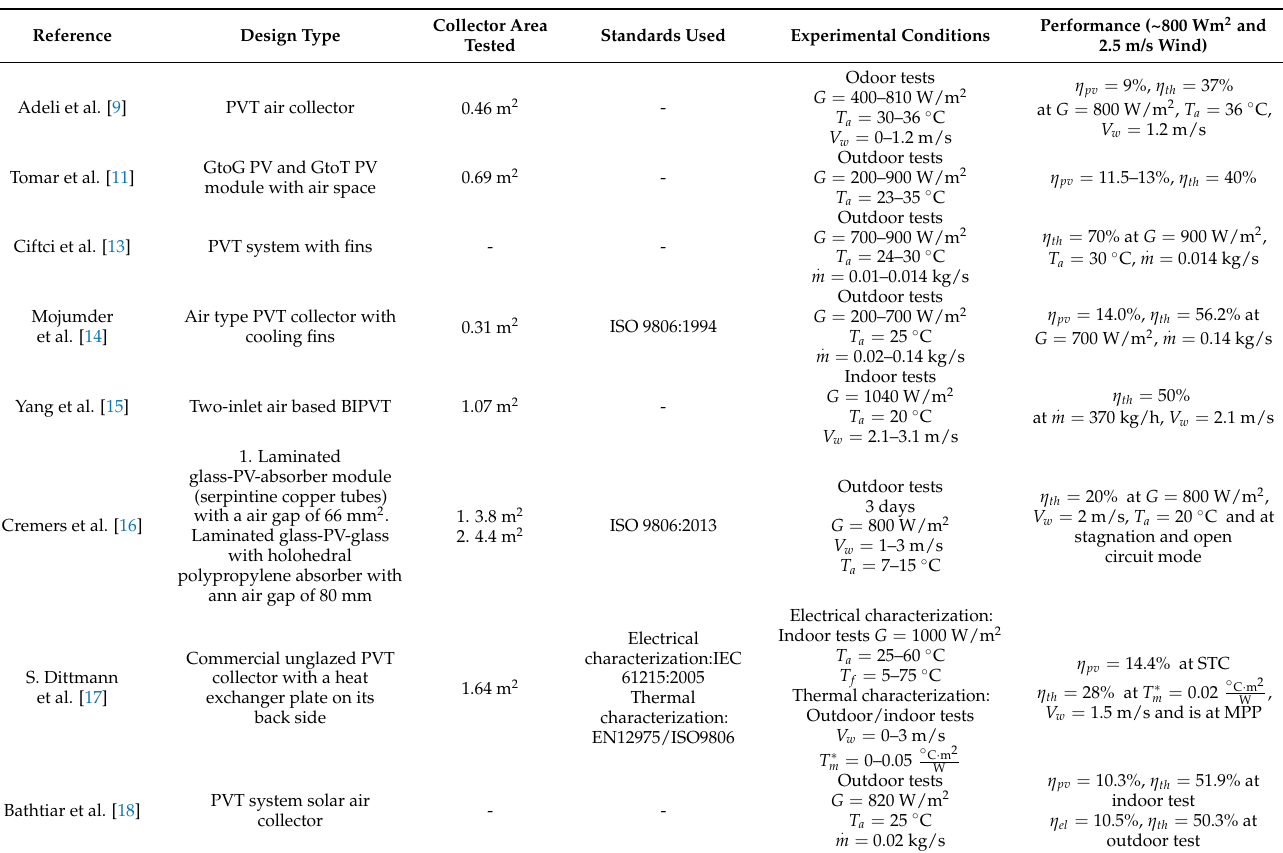
Table 1. Literature review